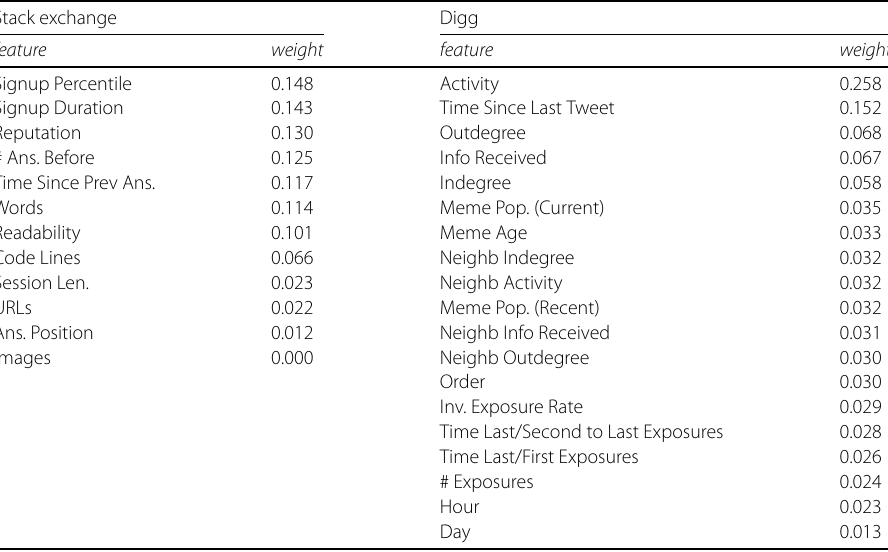
Table 2 Features found to be important by random forest in Stack Exchange and Digg, along with their relative weights Stack